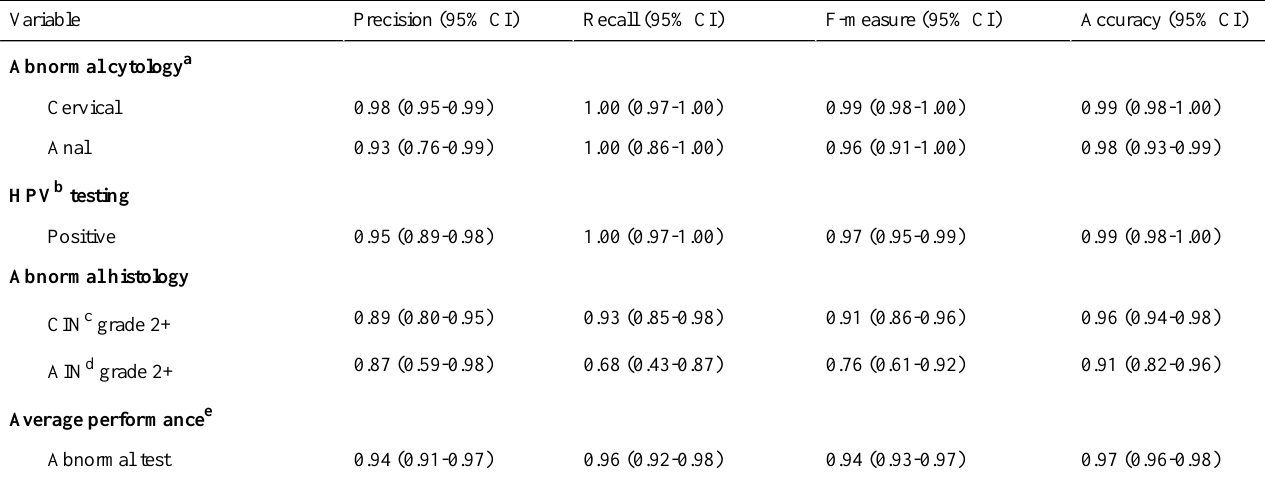
NLP algorithm missed 2 out of the 15 abnormal anal histology Table 2. Performance of NLP algorithm on the validation set, N =